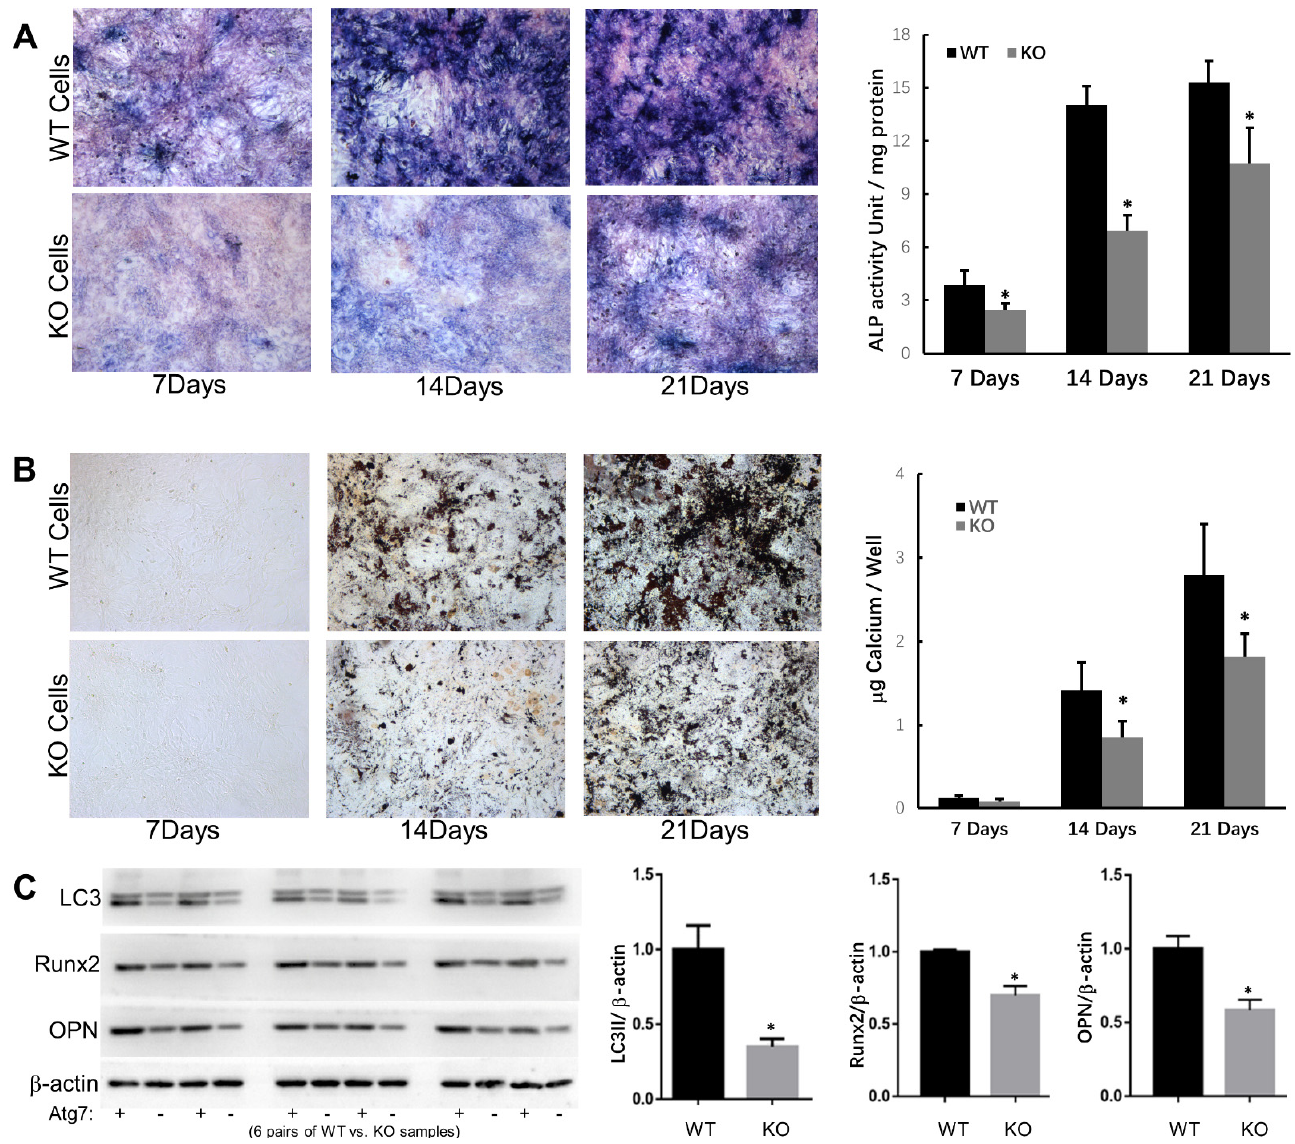
Figure 2. Differentiation and mineralization capacities were decreased in Atg7 KO osteoblasts. ( A ) Images of ALP staining and quantification of bone marrow cell cultures. ( B ) Images of von Kossa staining and qualification of bone marrow cell cultures. ( C ) Protein expression of LC3, Runx2, and osteopontin in WT and Atg7 KO osteoblasts. ( n = 6, * p < 0.05. Error bars represent SEM).